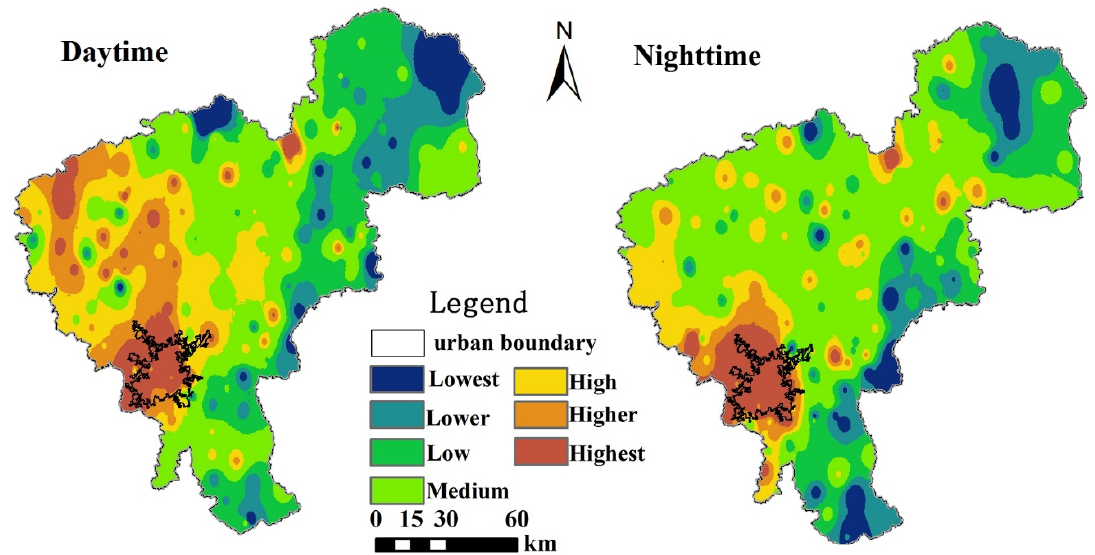
Figure 8. Mean daytime and nighttime air temperatures for Changchun during August 1–31, 2015.